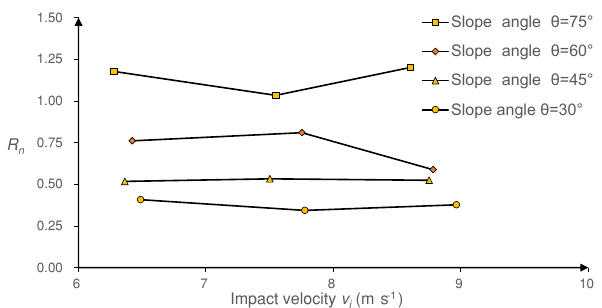
Figure 7. The mean value lines of the normal coefficient of restitu- tion R n versus the impact velocity.